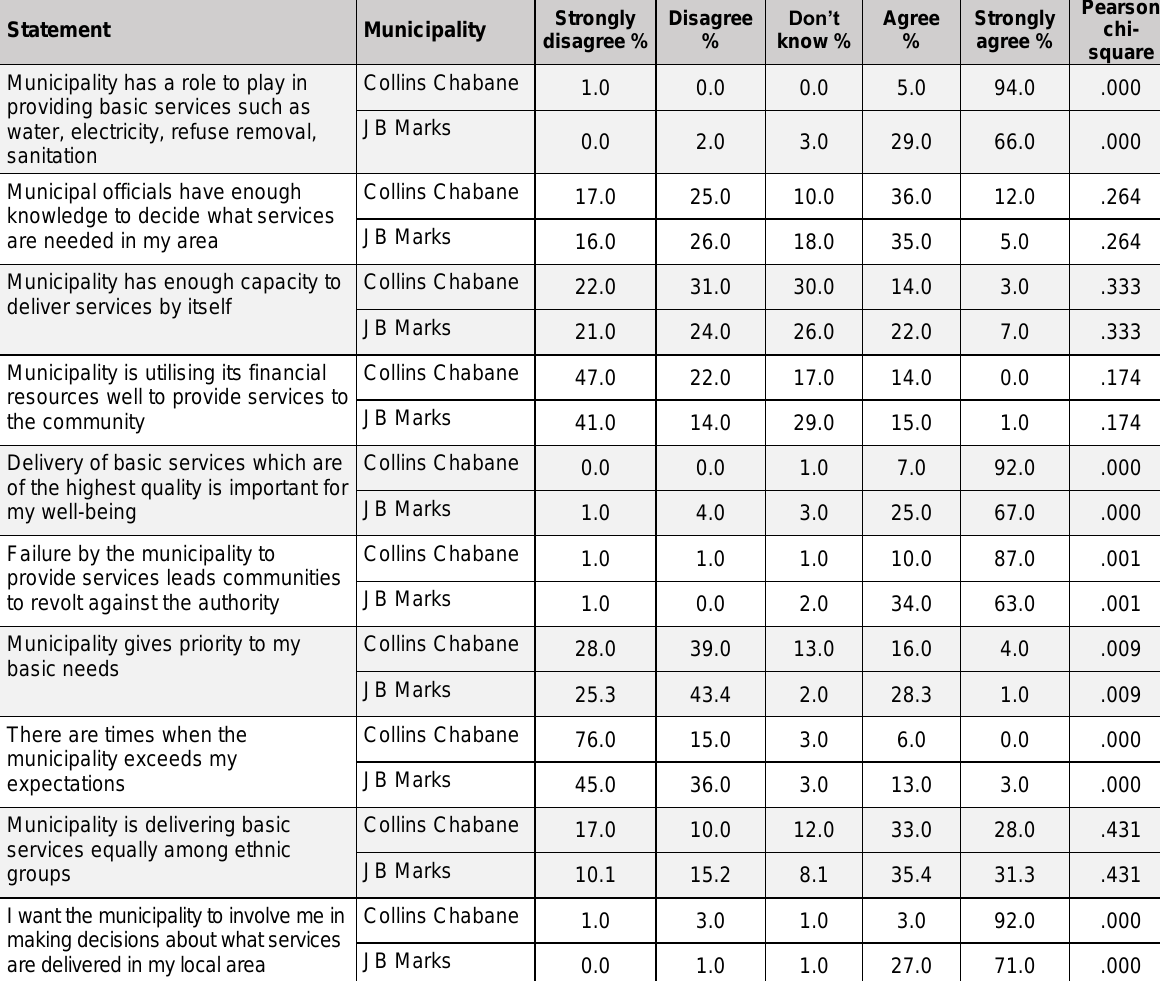
Table 5: Views on role of local government in the provision of services to households Statement Municipality